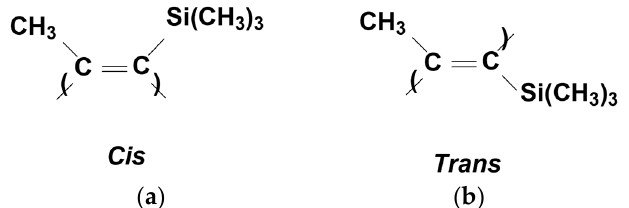
Figure 2. Repeating units of PTMSP with ( a ) cis - and ( b ) trans -configuration. Table 1. Synthesis conditions and characteristics of PTMSP.